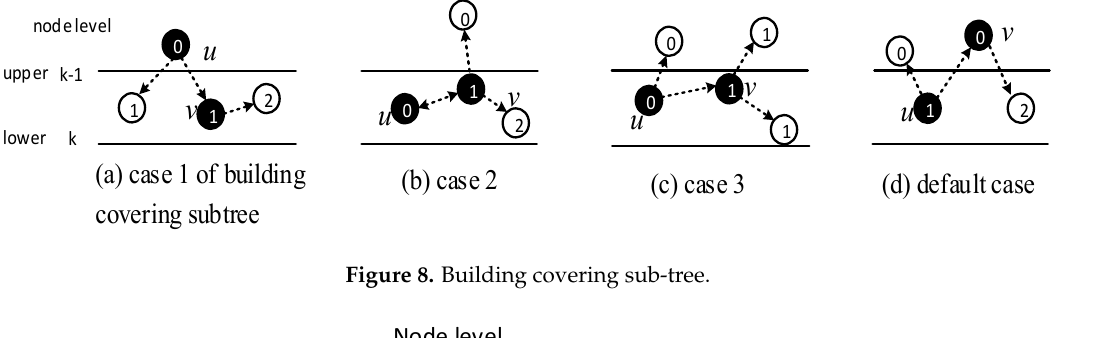
Figure 7. Broadcast backbone for LBAS.